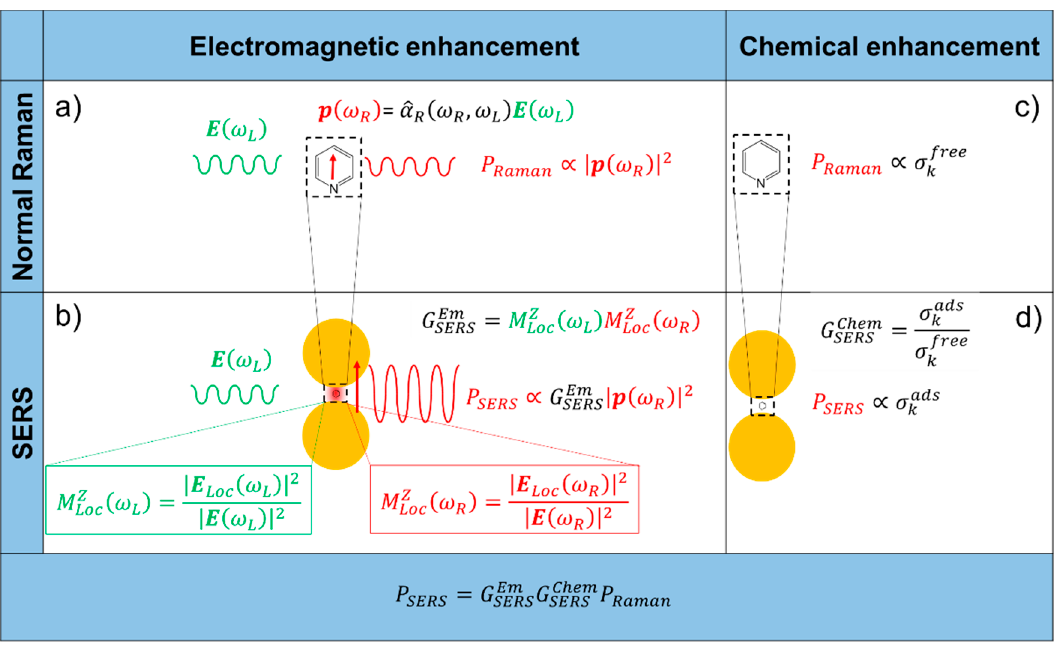
Figure 1. Electromagnetic enhancement. ( a ) Normal Raman. A laser radiation, with electric field E ( ω L ) oscillating at (angular) frequency ω L impinges on a molecule, characterized by a Raman polarizability tensor ˆ α R ( ω R , ω L ) . The laser induces a dipole oscillating at the Raman frequency (vertical red arrow, p ( ω R ) ); the Raman power radiated by this dipole is proportional to the square modulus of the dipole itself. ( b ) Surface enhanced Raman scattering (SERS) electromagnetic enhancement. When the molecule is placed near a plasmonic substrate, the electric field experienced by the molecule is 𝑬 (cid:3013)(cid:3042)(cid:3030) (cid:4666)𝜔 (cid:3013) ) , normally much stronger than the input laser 𝑬(cid:4666)𝜔 (cid:3013) ) ; this local field enhancement is quantified by 𝑀 (cid:3013)(cid:3042)(cid:3030)(cid:3027) (cid:4666)𝜔 (cid:3013) ) . Moreover, the presence of the plasmonic substrate also enhances the efficiency with which the dipole emits Raman radiation; this re-radiation enhancement is quantified by 𝑀 (cid:3013)(cid:3042)(cid:3030)(cid:3027) (cid:4666)𝜔 (cid:3019) ) . The total electromagnetic enhancement factor, within the |𝐸| (cid:2872) approximation, is defined as: 𝐺 (cid:3020)(cid:3006)(cid:3019)(cid:3020)(cid:3006)(cid:3040) = 𝑀 (cid:3013)(cid:3042)(cid:3030)(cid:3027) (cid:4666)𝜔 (cid:3013) )𝑀 (cid:3013)(cid:3042)(cid:3030)(cid:3027) (cid:4666)𝜔 (cid:3019) ) . Chemical enhancement. ( c ) Normal Raman. The vibrational modes of a molecule in free space are characterized by the cross-section(s) 𝜎 (cid:3038)(cid:3033)(cid:3045)(cid:3032)(cid:3032) ; ( d ) SERS chemical enhancement. The interaction with the plasmonic substrate modifies the structure of the molecule and consequently also the cross-section(s) of its modes ( 𝜎 (cid:3038)(cid:3028)(cid:3031)(cid:3046) ). The chemical (cid:3286)(cid:3276)(cid:3279)(cid:3294) . enhancement is quantified as 𝐺 (cid:3020)(cid:3006)(cid:3019)(cid:3020)(cid:3004)(cid:3035)(cid:3032)(cid:3040) = (cid:3097) (cid:3097) (cid:3286)(cid:3281)(cid:3293)(cid:3280)(cid:3280)